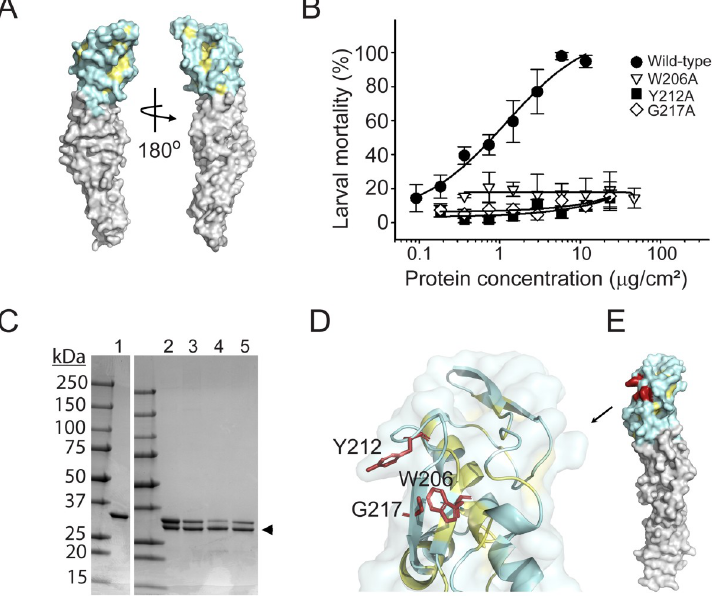
Fig 2. Domain I of Mpp75Aa1.1 comprises specific amino acids essential for insecticidal activity. (A) Surface representation of alanine-scanned residues in domain I. All domain I solvent-exposed amino acids substituted with alanine are colored in pale cyan. Partially buried amino acids are in pale yellow. (B) Concentration-dependent insecticidal activity of selected alanine variants against WCR larvae. Purified wild-type Mpp75Aa1.1 and variants W206A, Y212A, and G217A were used to treat WCR larvae in a diet overlay bioassay. All selected variants had significant reduction of insecticidal activity at concentrations as high as 23.5 μ g/cm 2 . Data points represent mean mortality with standard error. (C) Proteolytic stability profile between Mpp75Aa1.1 and derived alanine variants. Wild-type (lane 1), processed wild-type (lane 2), and variants W206A (lane 3), Y212A (lane 4), and G217A (lane 5) are shown. The processed form of the proteins is indicated with the black arrowhead. (D) Key WCR-active residues of Mpp75Aa1.1 domain I are shown in red sticks. (E) Surface representation of the same residues. All structural renditions were from PyMOL ™